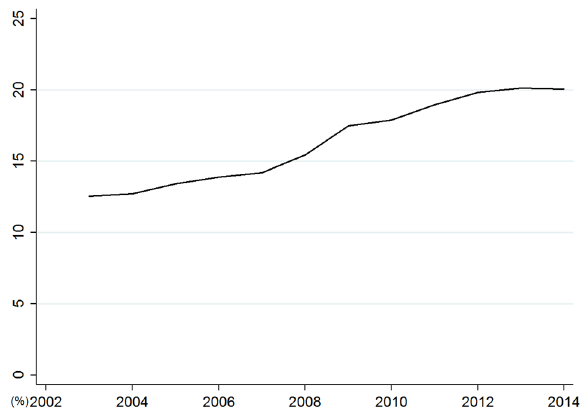
Figure 3. The ratio of local government spending to GDP.